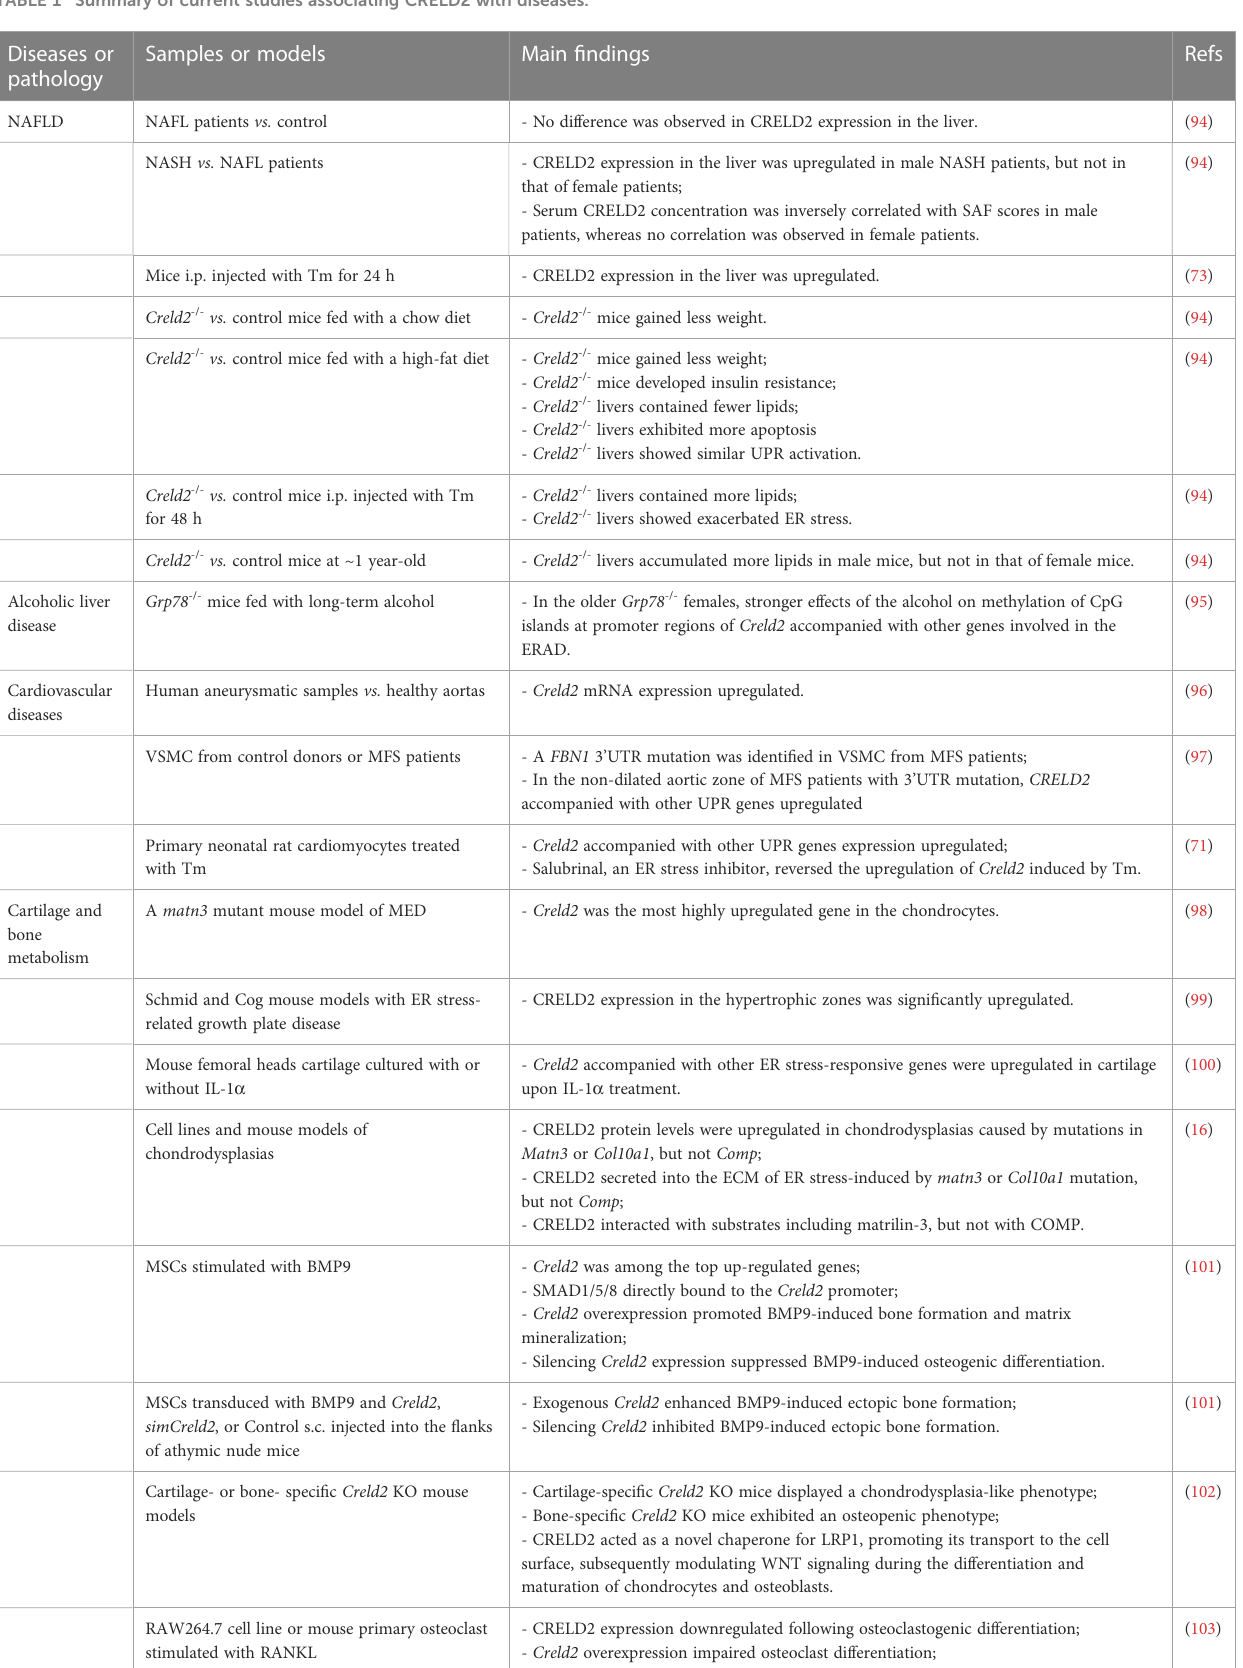
TABLE 1 Summary of current studies associating CRELD2 with diseases. Diseases or